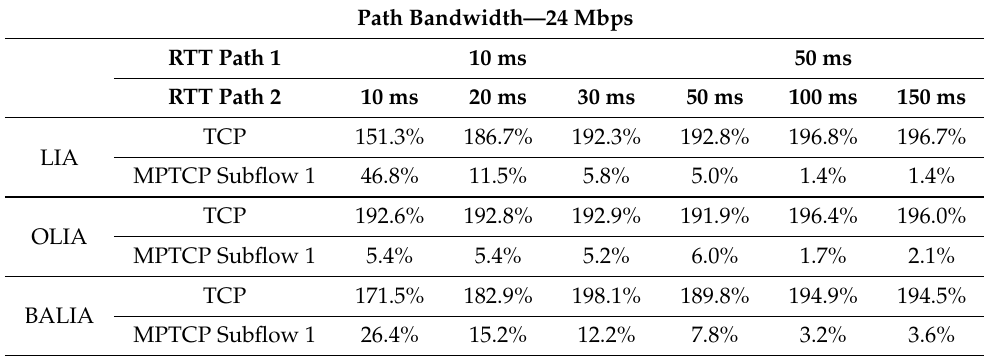
Table 3. Share of 24 Mbps bandwidth attained at Switch One-Disjoint Paths.